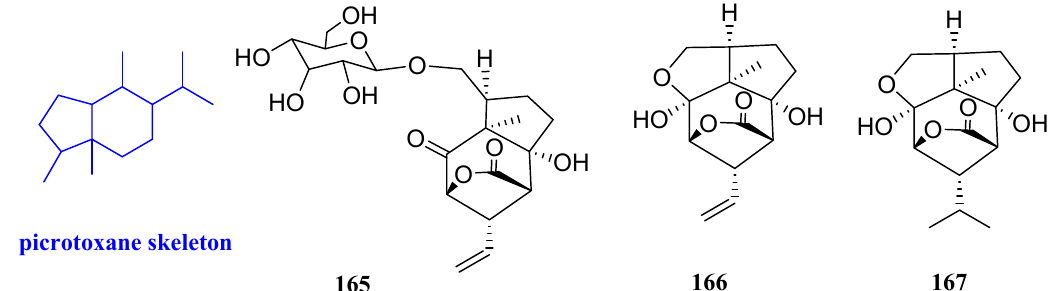
Figure 20. Structures of picrotoxane - type sesquiterpenoids 165 – 167 .